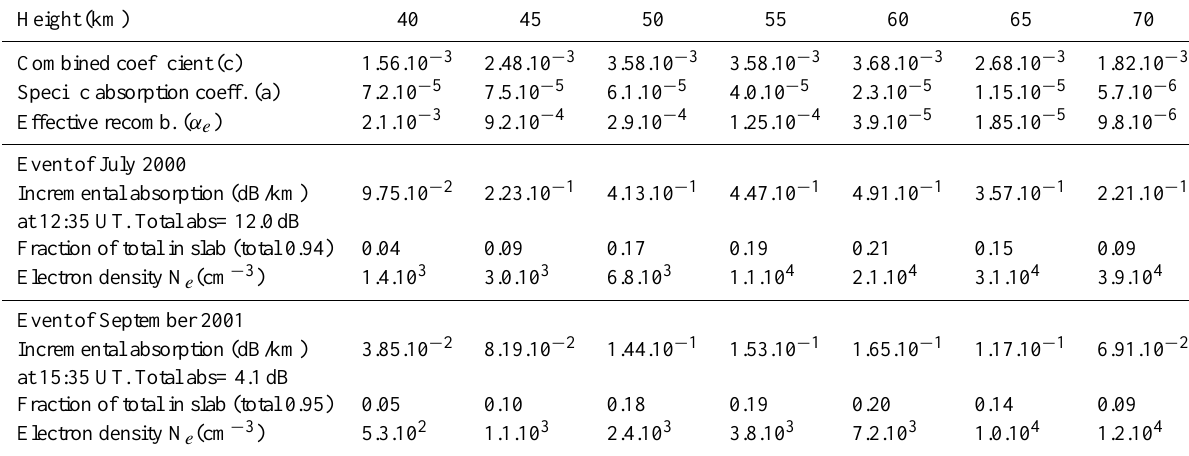
Table 1. Calculated, experimentally determined, and inferred parameters at 40–70km during daytime PCA events. Height (km)